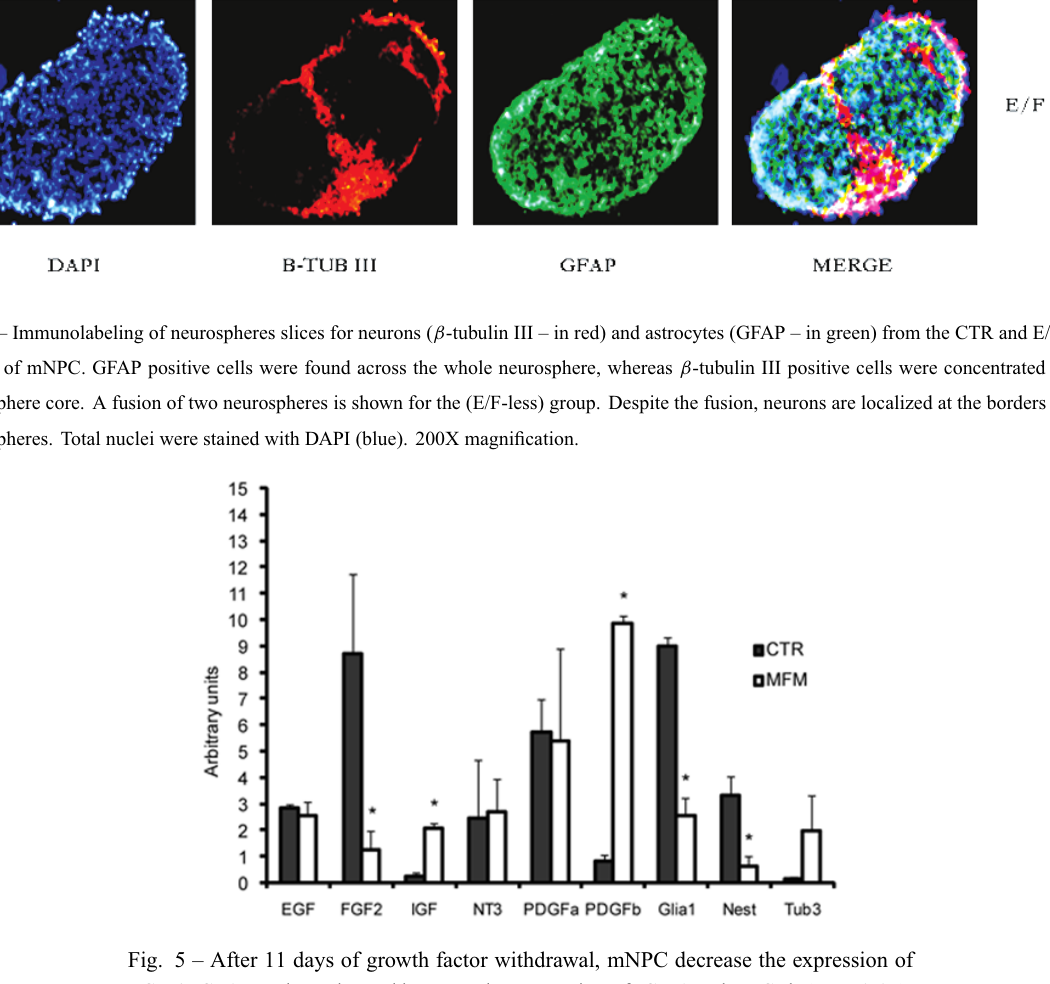
Fig. 5 – After 11 days of growth factor withdrawal, mNPC decrease the expression of FGF-2, GFAP and Nestin, and increase the expression of IGF-1 and PDGFb ( P < 0 . 05 )